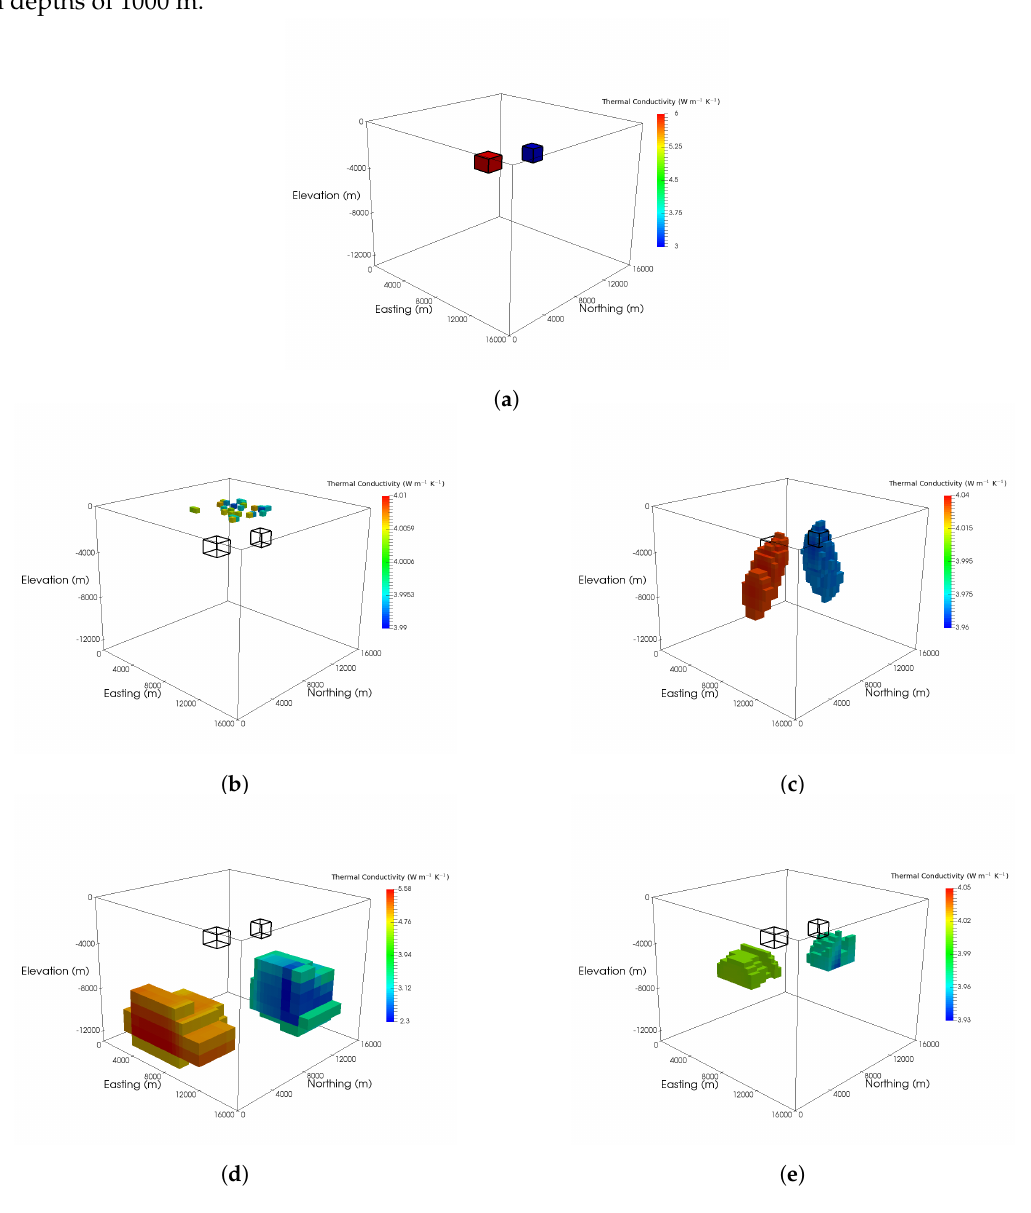
Figure 2. Inversions of synthetic surface heat flow data. ( a ) Block model of thermal conductivity, used to generate the synthetic data. The southwestern anomaly has a conductivity of 6Wm − 1 K − 1 , the northeastern anomaly has a conductivity of 3Wm − 1 K − 1 and the background conductivity is 4Wm − 1 K − 1 . ( b ) Inversion result using an l p norm for the model objective function, with p = 2 and no weighting. The recovered conductivity anomalies are all near the surface, demonstrating the need to weight the model objective function. ( c ) Inversion result with p = 2 and depth weighting. Two anomalous zones are imaged but the depth extent is not well-defined and the conductivities of the anomalies are close to the background conductivity. ( d ) Inversion result with p = 1 and depth weighting. The anomalies are located near at the bottom of the model, against the northern and southern sides. The conductivities of the anomalies are close to the conductivities in the true model. ( e ) Inversion result with p = 1 and sensitivity weighting. The depths to the tops of the recovered anomalies are greater than the true anomalies’ depths and their depth extent is greater. The conductivities of the anomalies are close to background